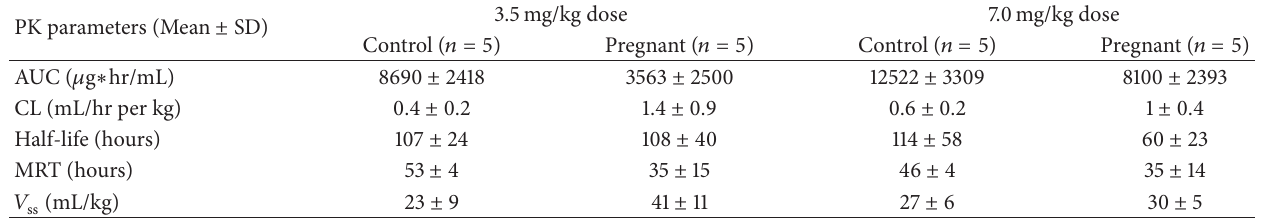
Table 1: Pharmacokinetic (PK) parameters of a hepatitis B immune globulin (HBIG) product in pregnant and nonpregnant guinea pigs. PK parameters (Mean ± SD)